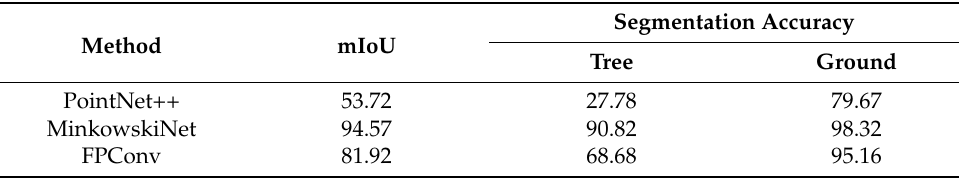
Table 1. Mean Intersection over Union (mIoU) (%) of the segmentation results.